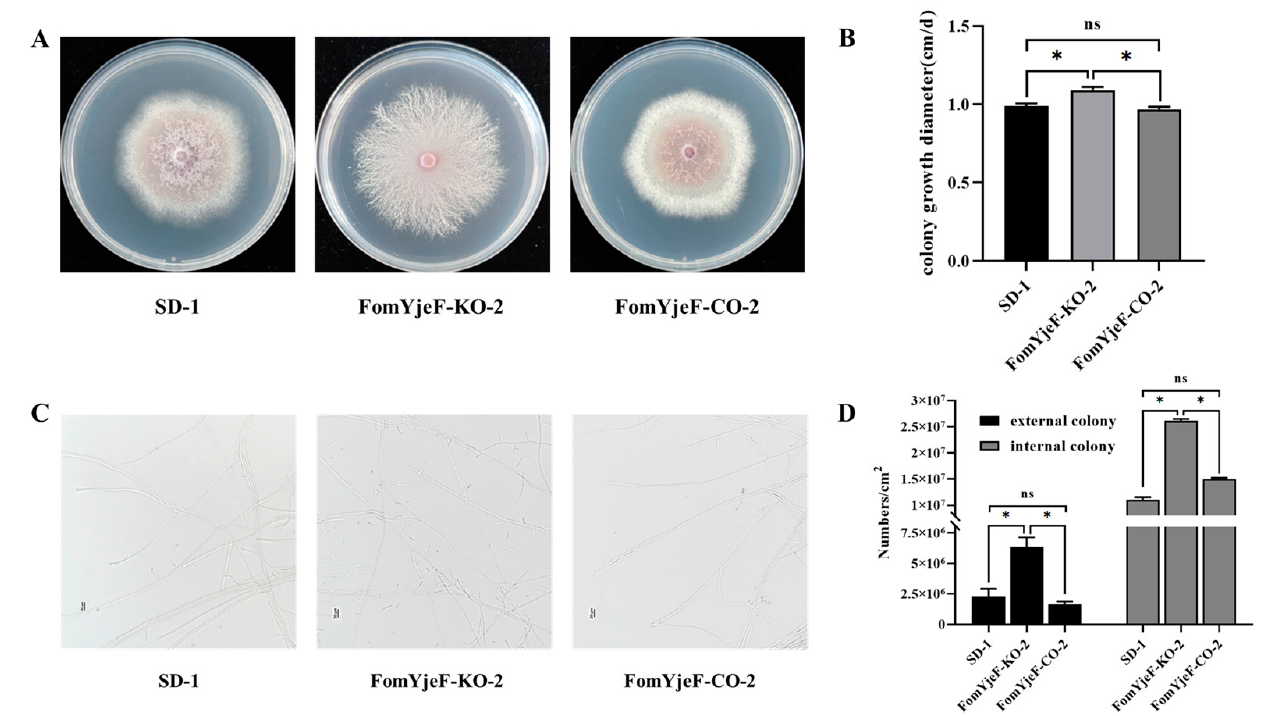
Figure 2. Vegetative growth, mycelial growth, and conidia production of wild-type SD-1, FomYjeF deletion, and FomYjeF -complemented strains. ( A ) Wild-type SD-1, FomYjeF-KO-2, and FomYjeF-CO- 2 were cultured on PDA plates at 28 ◦ C in dark for 5 days. ( B ) Growth rates. ( C ) Hyphae of wild-type SD-1 and mutant strains observed by EM. Bars:20 µ m. ( D ) Macroconidia production of wild-type SD-1 and all mutants were counted in per square centimeter after culturing on PDA for 4 days (See Figure S2 for the schematic diagram of sampling points). * over the histogram indicates standard error of the mean (SEM) at p < 0.05 (two-way ANOVA test). ns indicates no significant difference. Error bars represent the SEM of three biological replicates with three technical